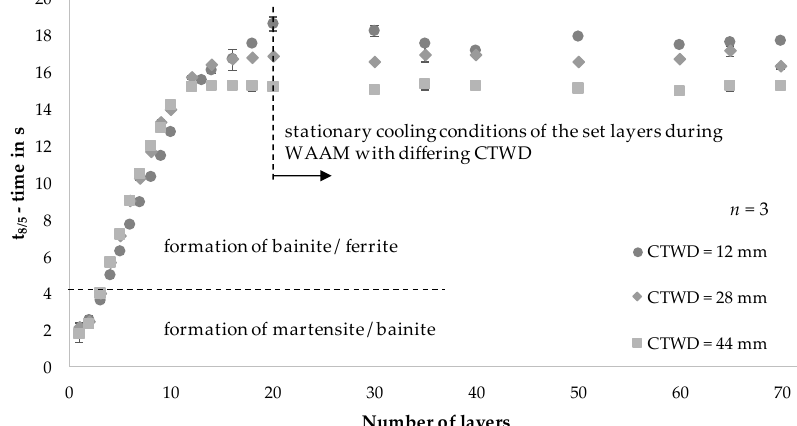
Figure 13. Analysis of the t 8/5 -time in dependence on the number of layers and CTWD for U = 20 V; v wire = 5 m/min and v weld = 0.4 m/min (mean values of 3 measuring points per layer).